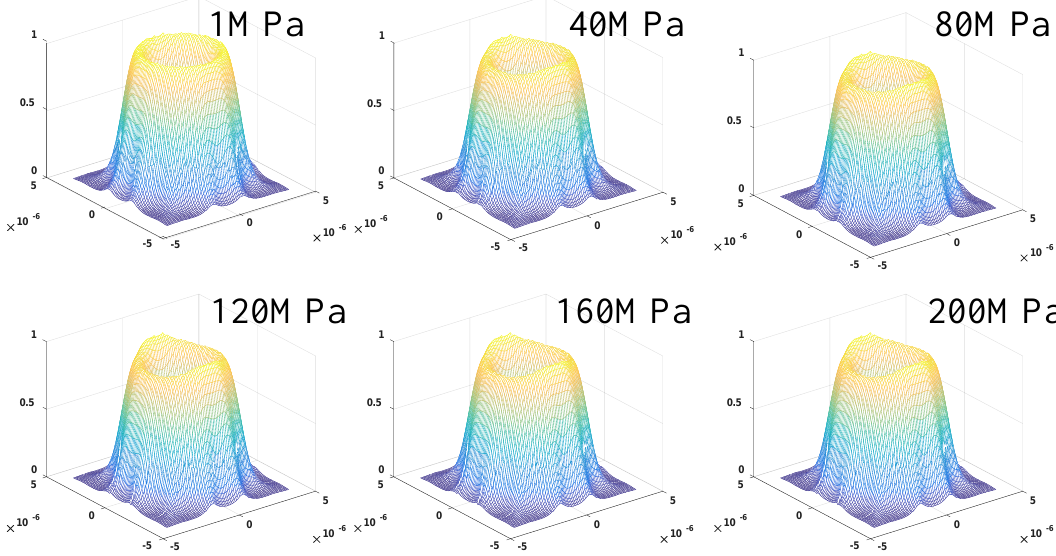
Figure 5. The normalized intensity distribution of HE31 under 1–200 MPa stress in the y direction.